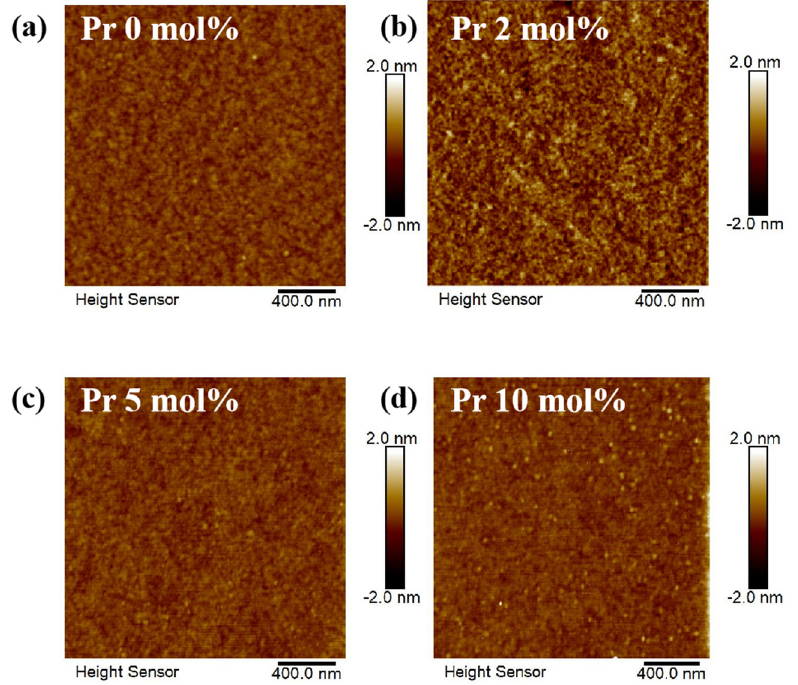
Figure 4. Images of In-Pr-O films with with Pr ratios of ( a ) 0, ( b ) 2, ( c ) 5, and ( d ) 10 mol% by atomic force microscopy.